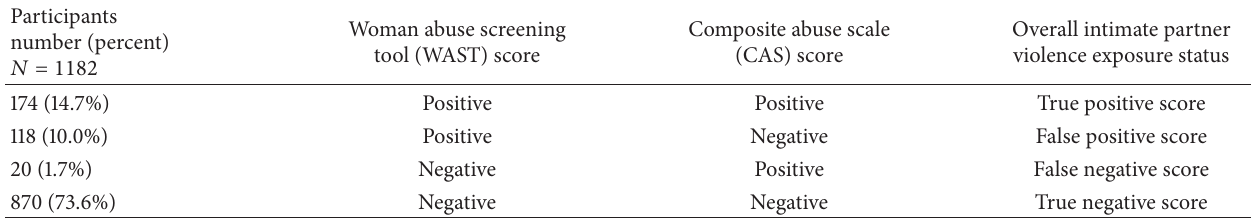
Table 2: Quantitative subanalysis results: summary of intimate partner violence exposure status across screen and nonscreen